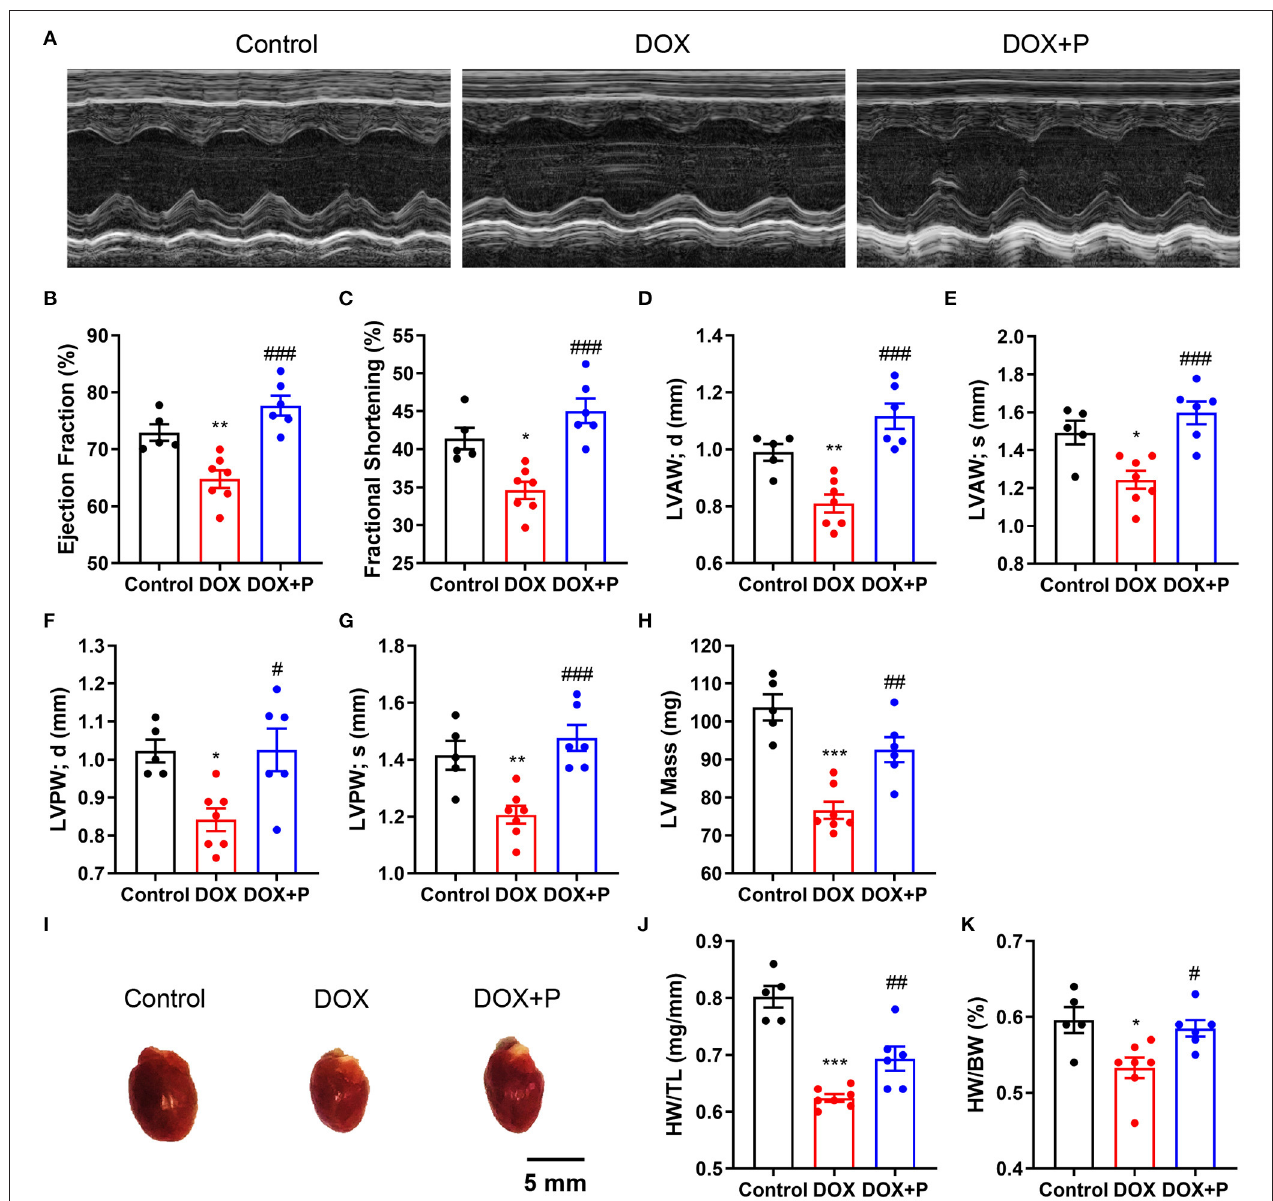
FIGURE 1 | Effects of periplocymarin on cardiac function and heart weight after 3-day doxorubicin (DOX) treatment in mice. The cardiac function of the mice was determined by the echocardiography in M-mode on the aspect of the short axis. (A) Representative images of echocardiography. (B–H) The ejection fraction (EF%) (B) , fractional shortening (FS%) (C) , left ventricular anterior diastolic wall thickness (LVAW; d) (D) , left ventricular anterior systolic wall thickness (LVAW; s) (E) , left ventricular posterior diastolic wall thickness (LVPW; d) (F) , left ventricular posterior systolic wall thickness (LVPW; s) (G) and left ventricular mass (H) were calculated according to the M-mode echocardiography. Data are presented as mean ± SEM; n = 5–7, * p < 0.05, ** p < 0.01, *** p < 0.001 vs. control; # p < 0.05, ## p < 0.01, ### p < 0.001 vs. DOX. (I) The mice were euthanized and the representative images of the hearts were shown. Scale bar, 5mm. (J) The ratios of heart weights to tibia length were calculated. Data are presented as mean ± SEM; n = 5–7. *** p < 0.001 vs. control, ## p < 0.01 vs. DOX. (K) The ratios of heart weights to body weights were calculated. Data are presented as mean ± SEM; n = 5-7. * p < 0.05 vs. control, # p < 0.05 vs.